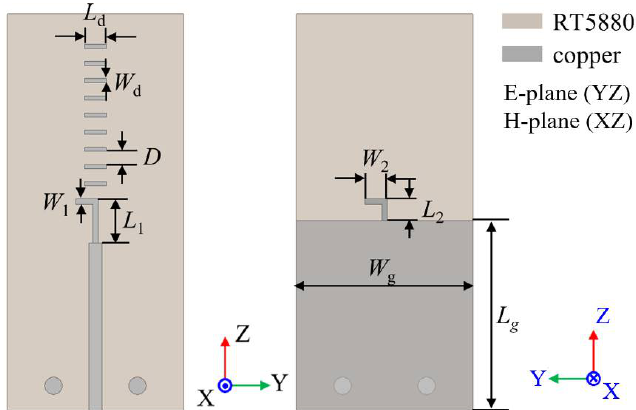
Figure 3. Yagi antenna geometry with design parameters (units: mm): W g = 20, L g = 22, W 1 = 0.6, L 1 = 5, L 3 = 2.5, L 2 = 2.5, W d = 0.6, L d = 2.5, D = 1.2.